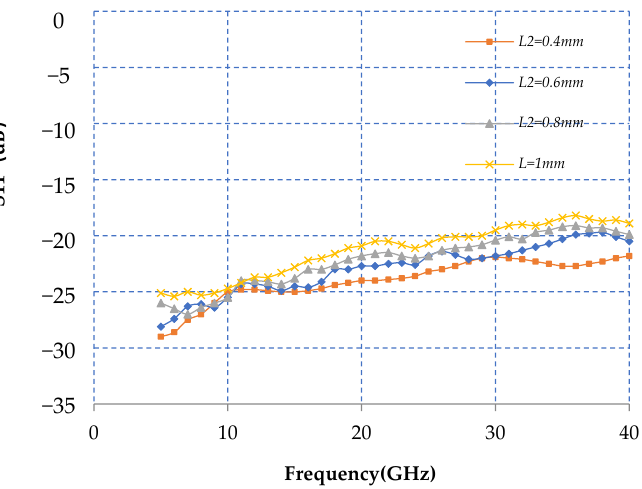
Figure 14. Return loss corresponding to the length of the gradually opening air coaxial.